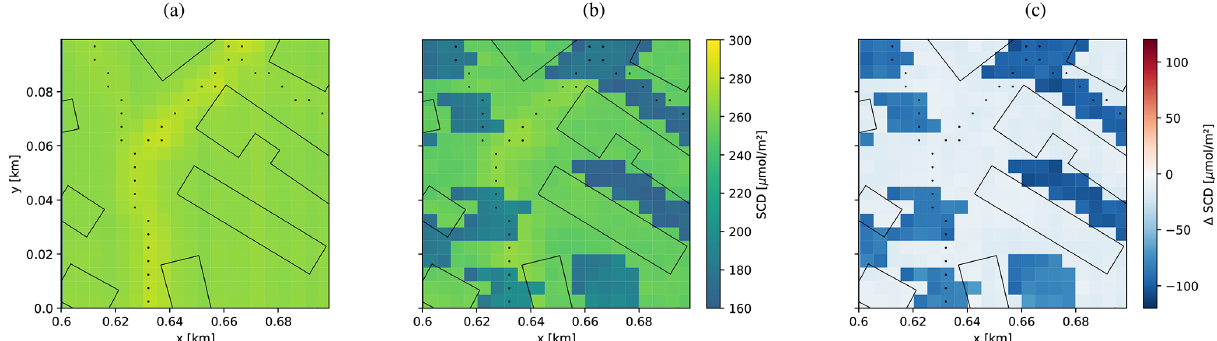
Figure 10. SCDs over a small subdomain computed from high-resolution 3D-box AMFs simulated without (a) and with (b) buildings as well as the difference between both (c) . In the simulation, the sun was located in the west at a SZA of 60 ◦ . The albedo of roofs, walls and streets was set to 0.1. Roads are included as black dots and building contours as black lines.